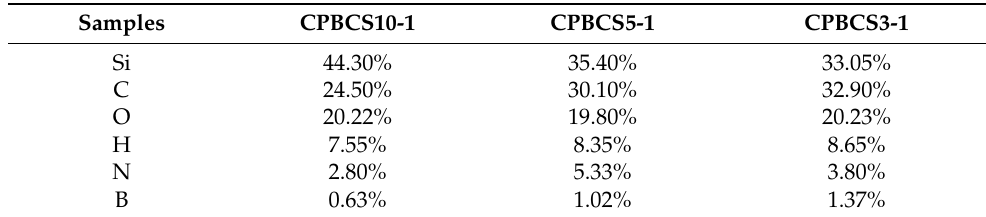
Table 2. Polymer element content of crosslinked polymer CPBCS solids.